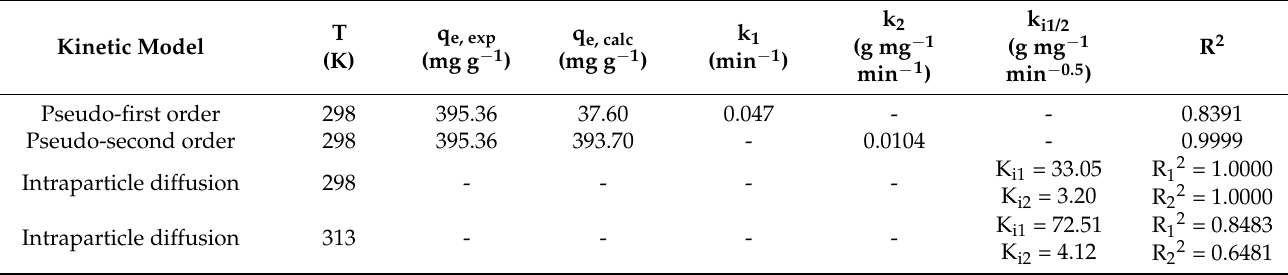
Table 2. Kinetic parameters of the models shown in Figure